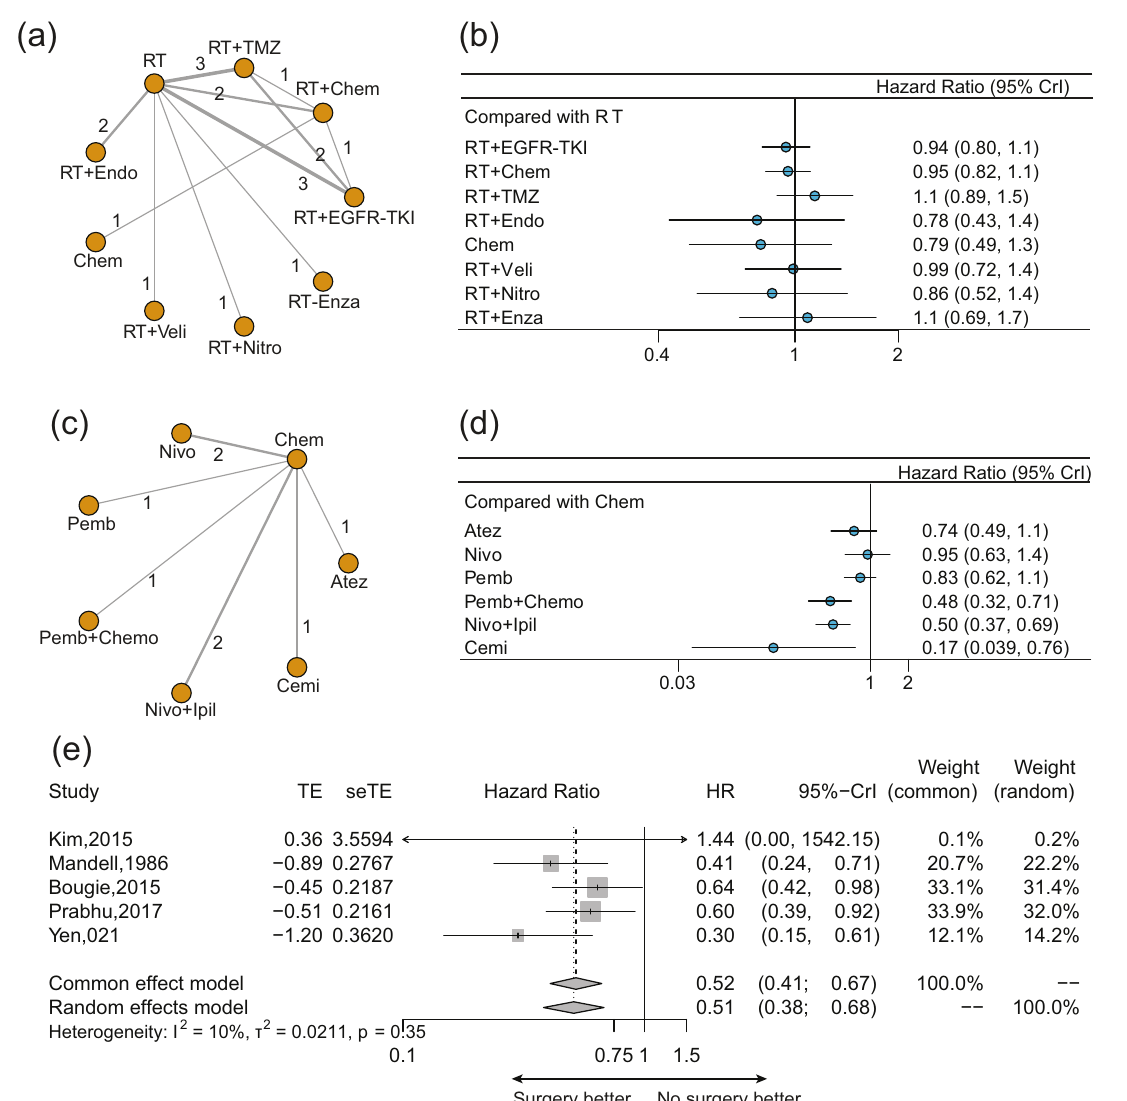
Figure 2: Pooled result of OS for di ff erent treatments for BMs from EGFR/ALK - negative/unselected NSCLC. ( a ) Network diagram and ( b ) forest plot of OS for di ff erent treatments compared with radiotherapy alone in newly diagnosed BMs. ( c ) Network diagrams and ( d ) forest plot of OS for di ff erent treatments compared with chemotherapy alone in previously treated BMs. ( e ) Forest plot of OS comparing surgery with radiotherapy alone. Each node in the network diagram represents one treatment, and the numbers represent direct head - to - head comparisons. Abbreviations: RT, radiotherapy; TMZ, temozolomide; Chem, chemotherapy; EGFR - TKI, epidermal growth factor receptor - tyrosine kinase inhibitors; Enza, enzastaurin; Nitro, nitroglycerin; Veli, veliparib; Endo, endostatin; Atez, atezolizumab; Cemi, cemiplimab; Nivo, nivolumab; Ipil, ipilimumab; and Pemb,